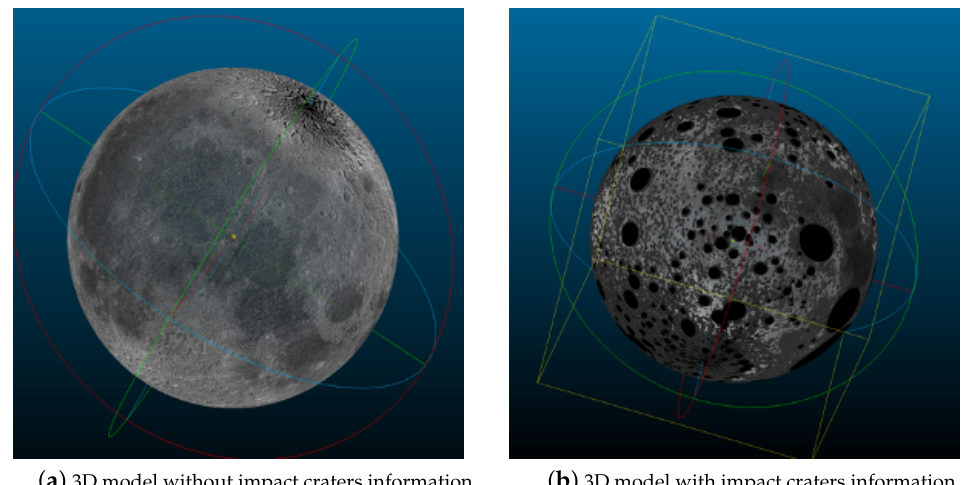
Figure 18. Visualization after 4096 times downsampling of all point clouds. ( a ) presents a 3D model without impact craters information,and ( b ) presents a 3D model with impact craters in